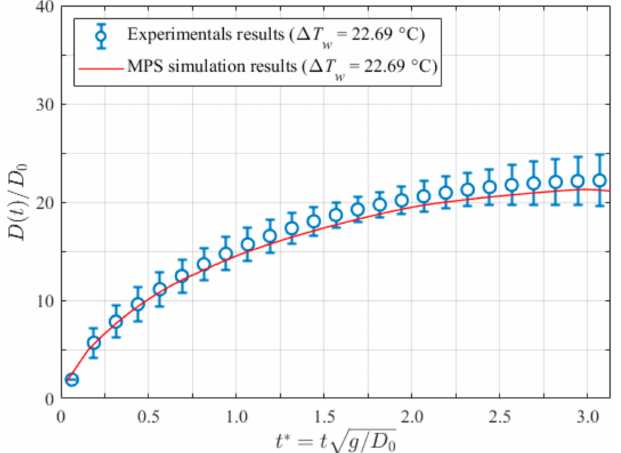
Figure 15. Comparison of the bubble diameter variation between numerical simulations and experi- ments on the 100 bilayer LbL